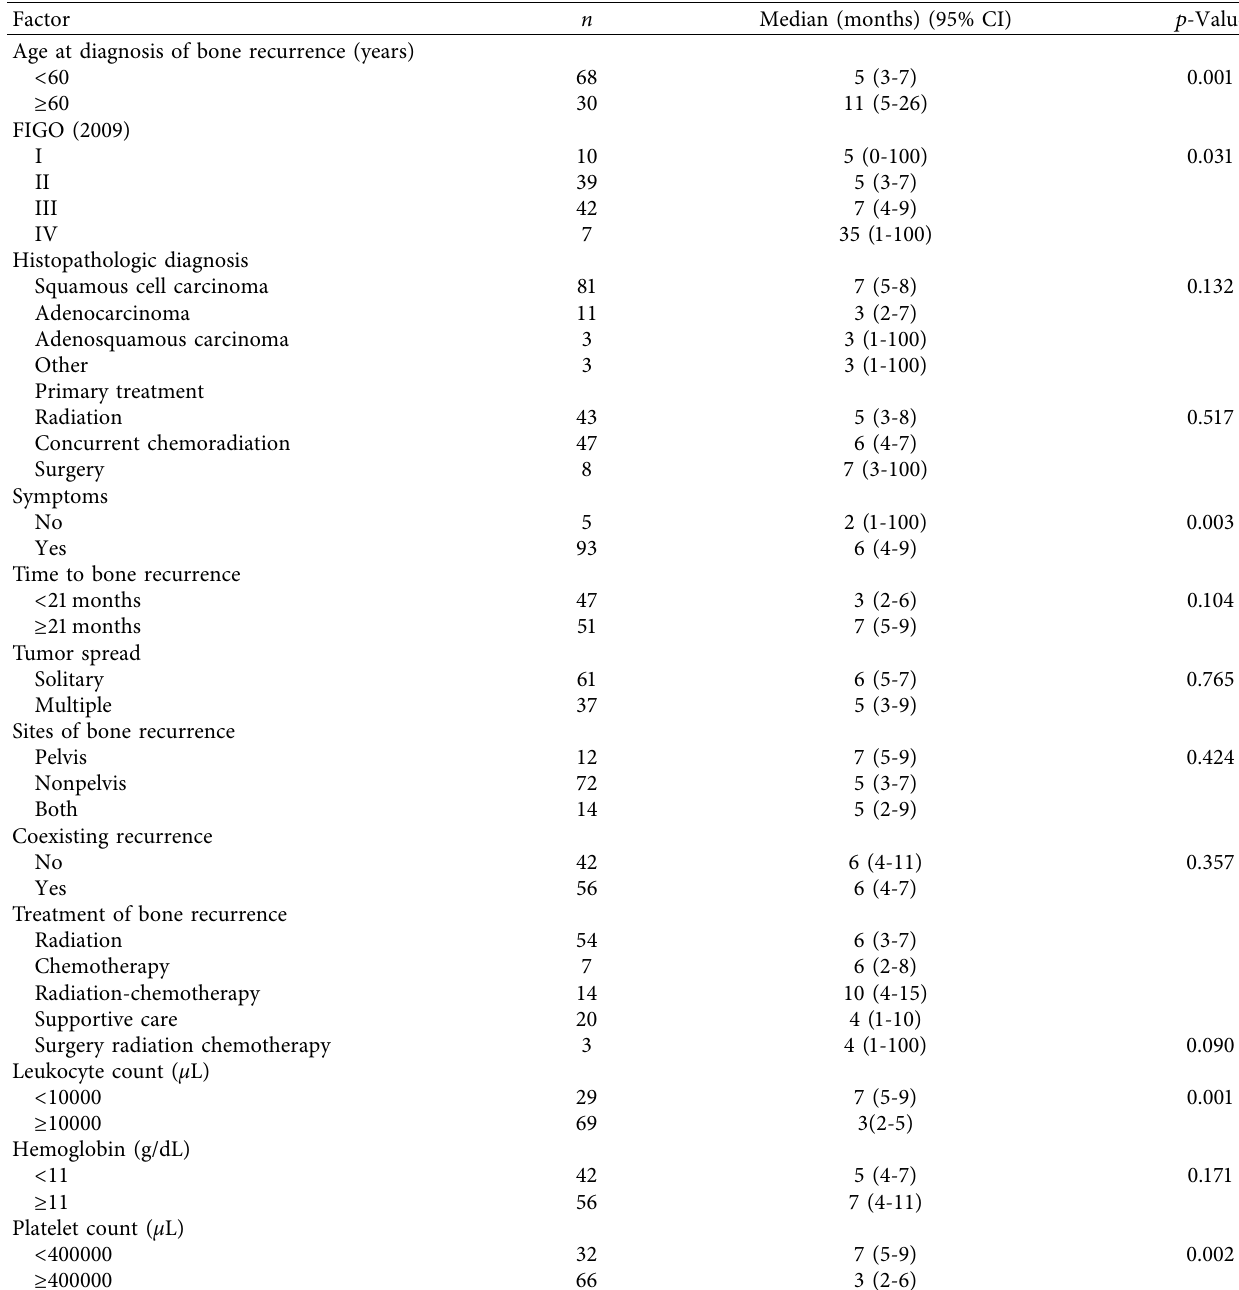
Table 2: Univariable clinical prognostic factors for overall survival.